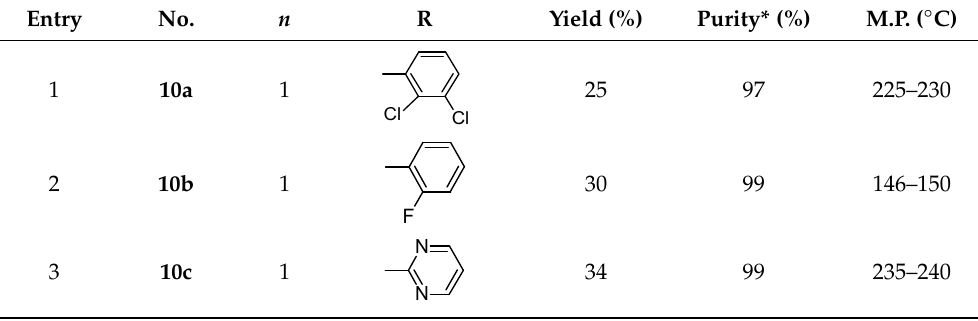
Table 5. Analytical data of the library 10a – 10k. M.P.—melting point.